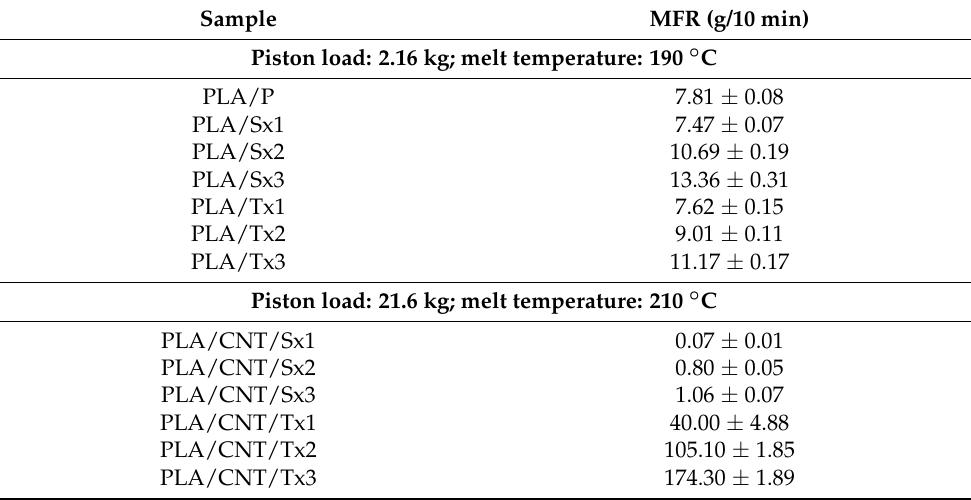
Table 8. MFR results for individual